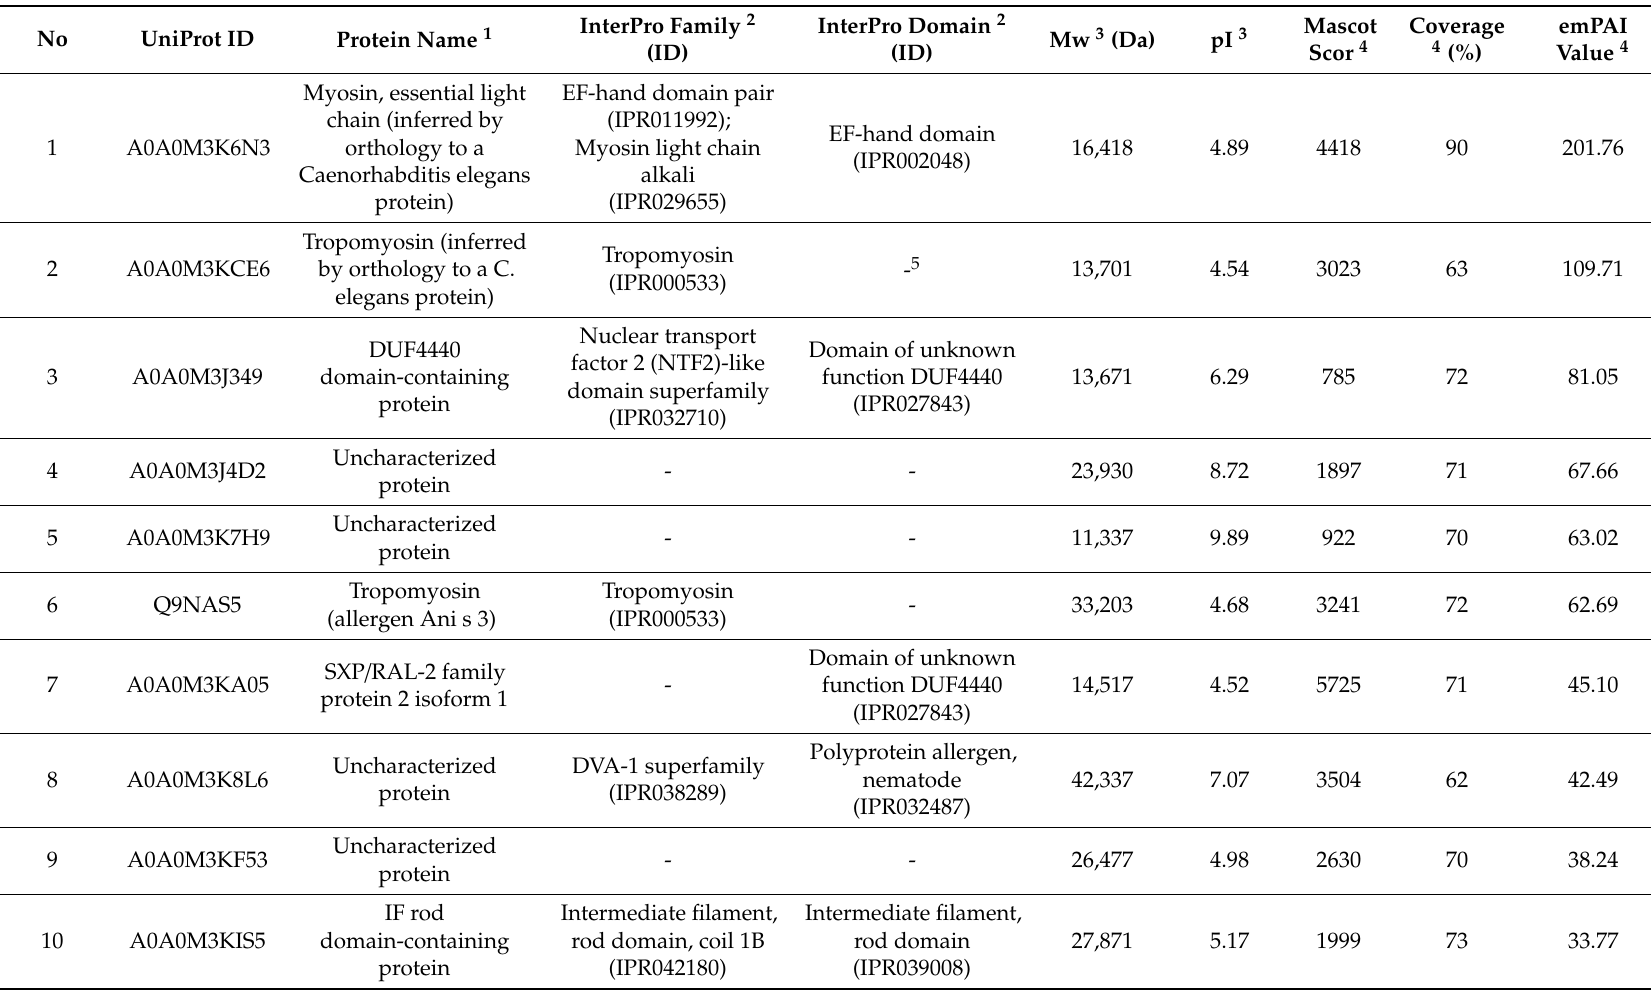
Table 1. The top 25 most abundant proteins of Anisakis simplex identified by liquid chromatography-tandem mass spectrometry (LC-MS /